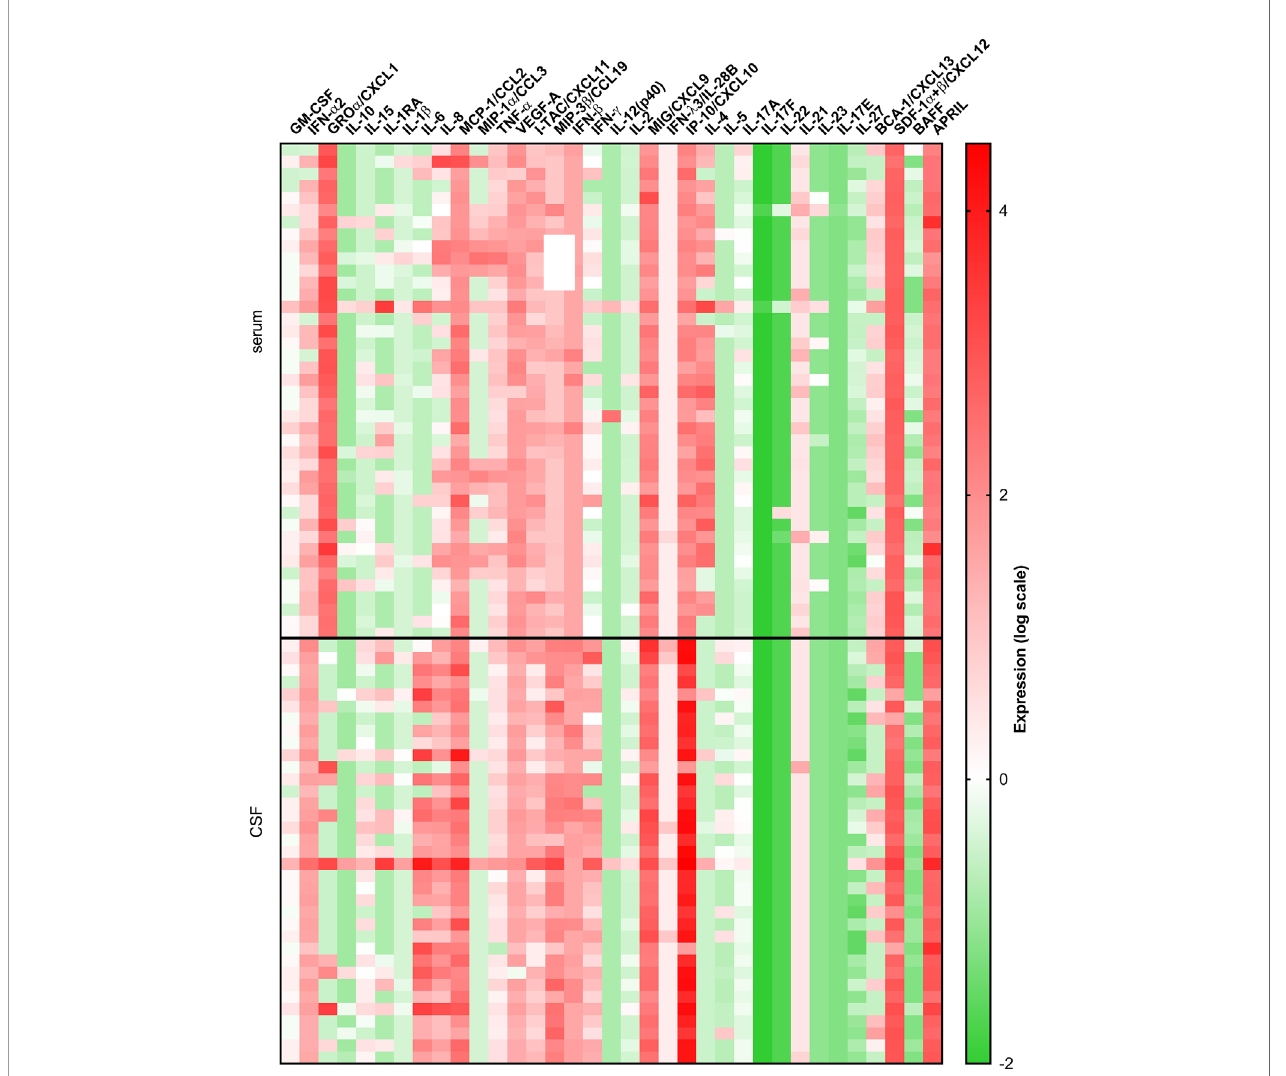
FIGURE 2 | A heatmap illustrating concentrations of 35 cytokines and chemokines measured in serum and CSF of 41 VBT patients. Cytokine concentrations are visually presented on a log10 scale with red and green indicating high and low expression, respectively (refer to color bar).